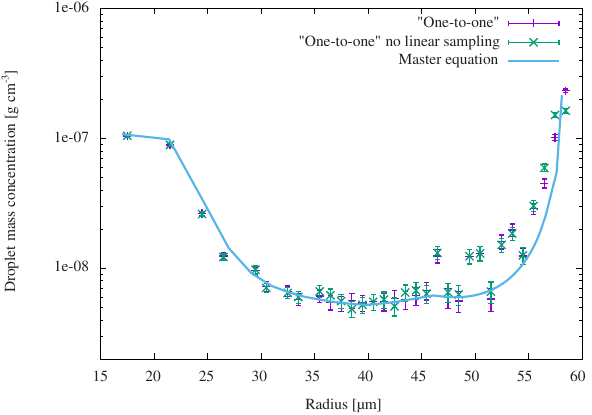
Figure 1. Mass of droplets per size bin at t = 2500s. Bins are 1µm wide. Points depict an averaged result of (cid:127) = 10 4 “one-to-one” sim- ulations with and without linear sampling of collision pairs. Error bars show a 95% confidence interval. The line depicts a numerical solution of the master equation (see Fig. 8 in Alfonso and Raga, 2017, data courtesy of L.